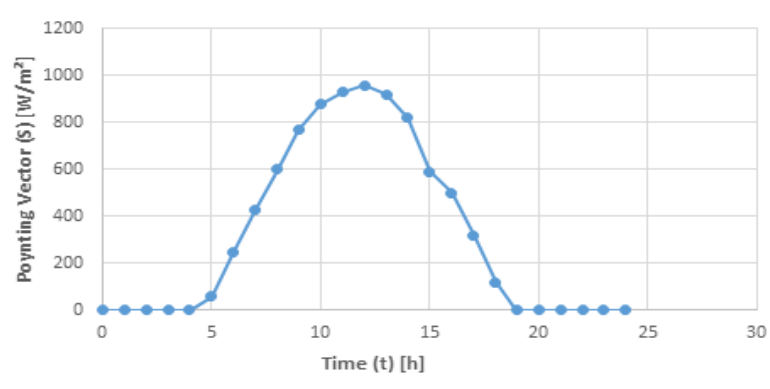
Figure 17. Solar radiation versus time.